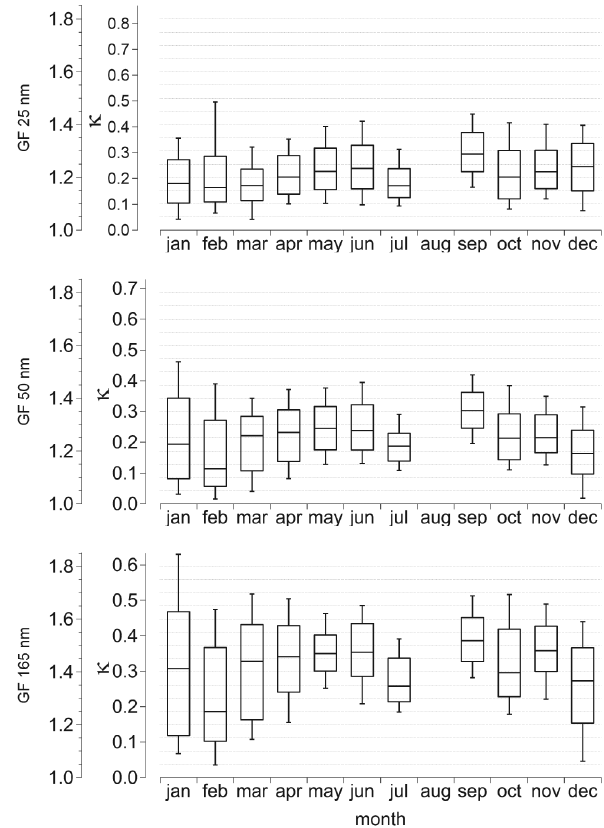
Figure 3. Monthly variation of hygroscopic growth factors (GFs) and kappa values ( κ) measured at RH90 for particles in the nucle- ation mode (top panel), Aitken mode (middle panel) and accumula- tion mode (bottom panel). The figure shows the median GF and κ value, with the bottom and top sides of the box giving the 25th and 75th percentiles, and the extremities the 10th and 90th